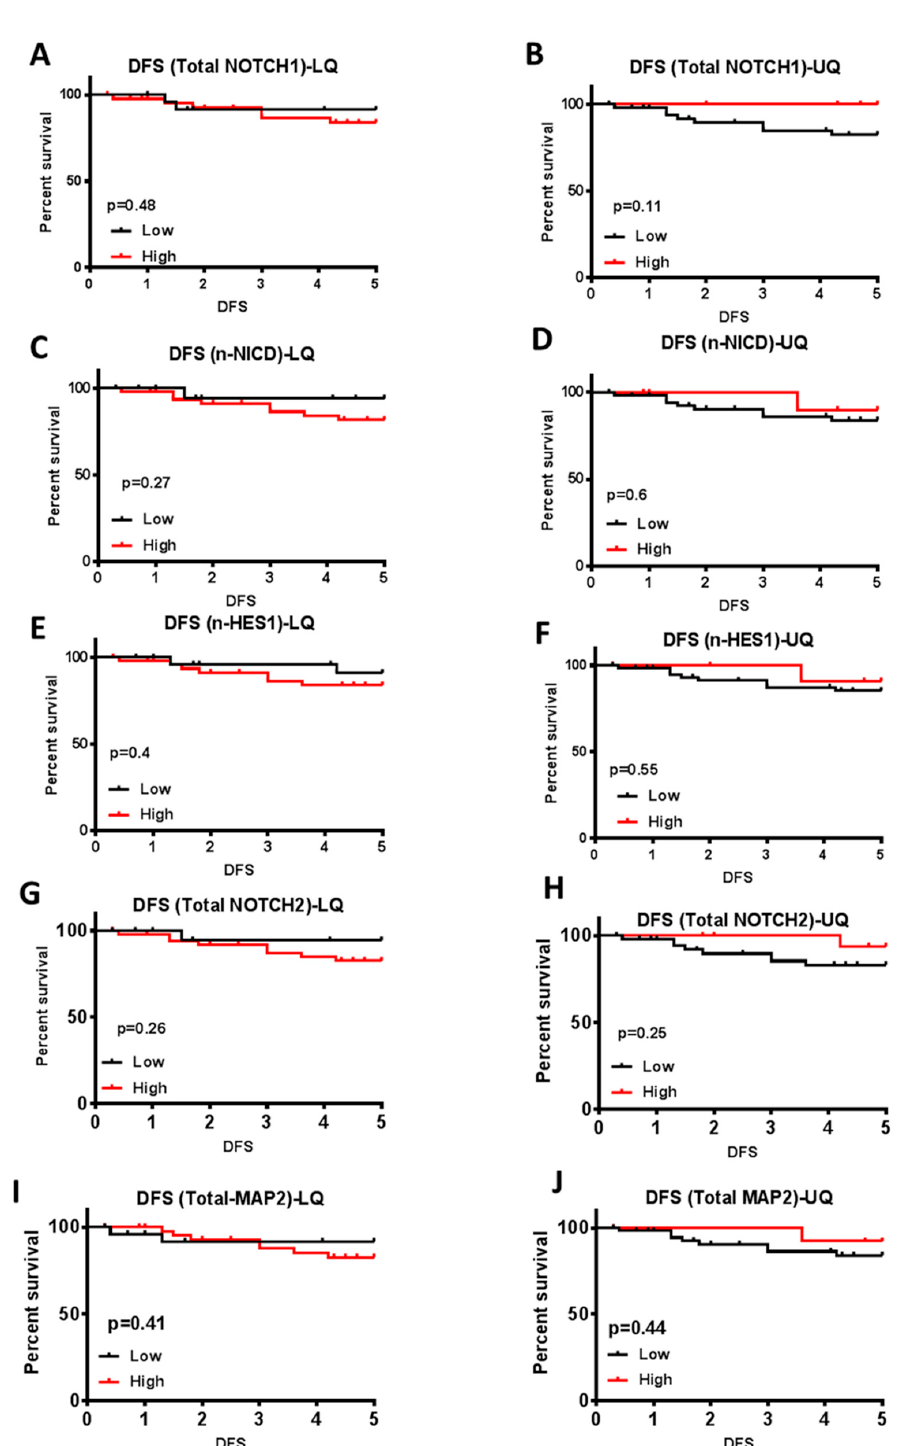
Figure 4. Kaplan–Meier Survival analysis for five year-disease free survival of patients diagnosed with primary melanoma tumors. ( A ) Low total NOTCH1 = optical density of 0.045 or less (lower quartile). ( B ) Low total NOTCH1 = optical density of 0.086 or less (upper quartile). ( C ) Low NICD = optical density of 0.235 or less (lower quartile). ( D ) Low NICD= optical density of 0.298 or less (upper quartile). ( E ) Low nuclear HES1= optical density of 0.017 or less (lower quartile). ( F ) Low nuclear HES1 = optical density of 0.038 or less (upper quartile). ( G ). Low total NOTCH2 = optical density of 0.0985 or less (lower quartile). ( H ) Low total NOTCH2 = optical density of 0.1655 or less (upper quartile). ( I ) Low nuclear MAP2 = optical density of 0.066 or less (lower quartile). ( J ) Low nuclear MAP2 = optical density of 0.172 or less (upper